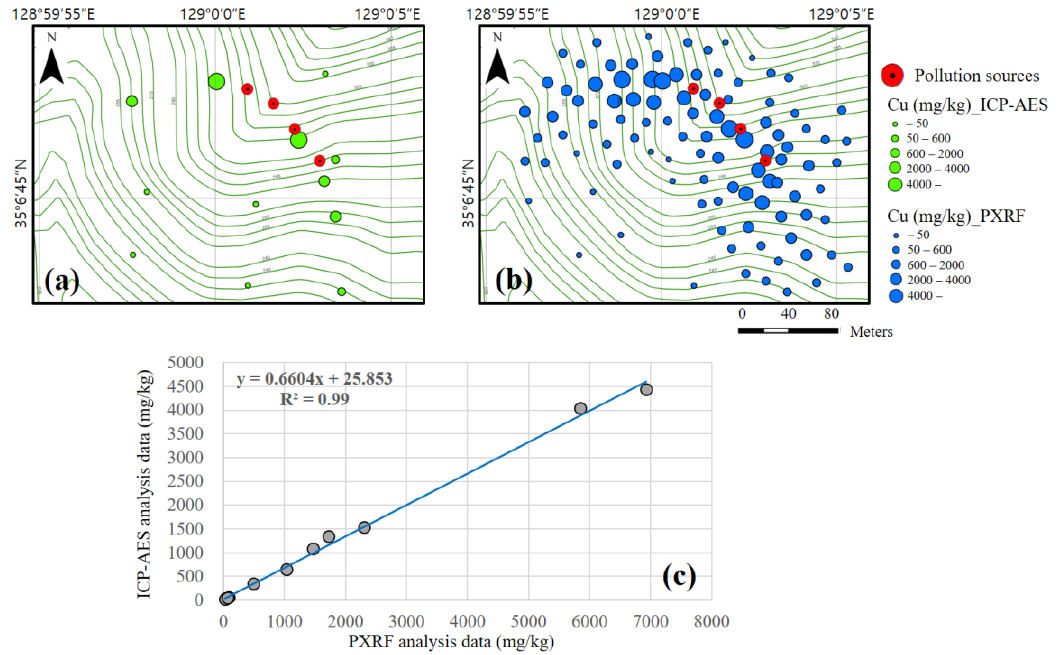
Figure 2. Element analysis results: Copper concentrations as analyzed using ( a ) ICP-AES and ( b ) PXRF; ( c ) Correlation between ICP-AES and PXRF analysis data. Table 1. Copper concentration results determined using ICP-AES and PXRF for 12 sampling points.